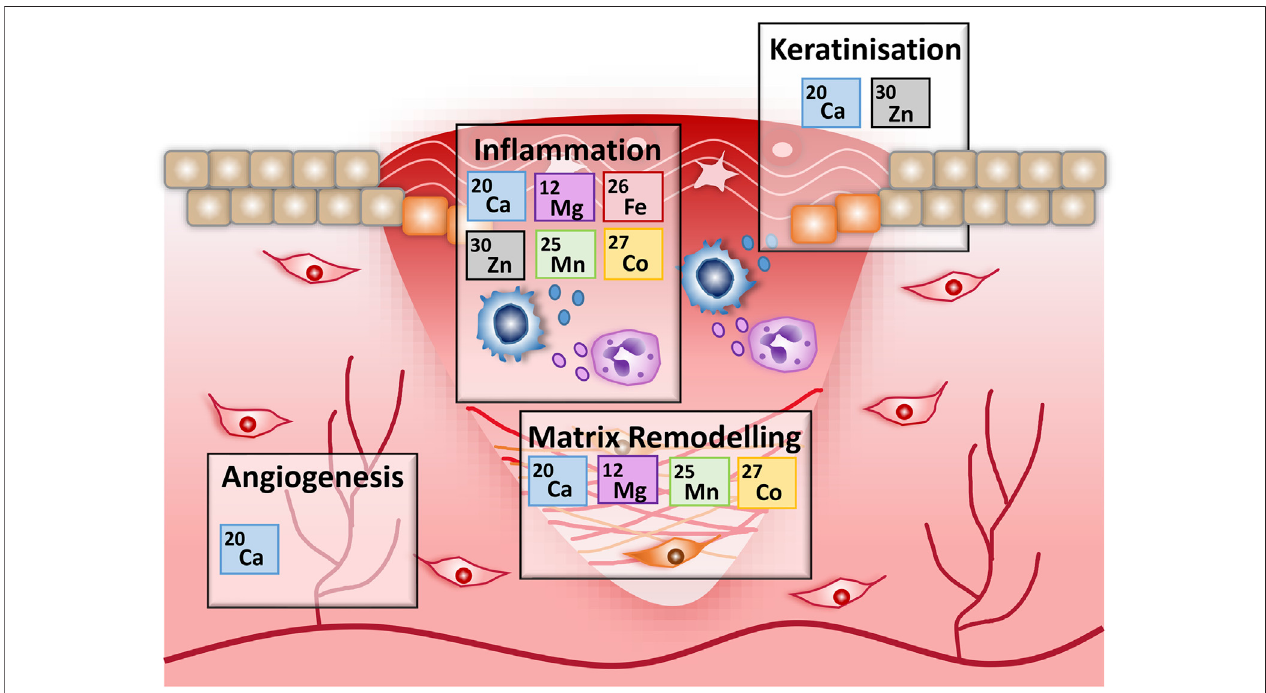
FIGURE 7 | An overview of the potential roles for metals in wound repair. Schematic outlining the key metal associations identi fi ed in this work, for speci fi c wound healing stages. Associations are based on metal gene list overrepresentation and functional annotation analysis of genes differentially expressed during murine wound